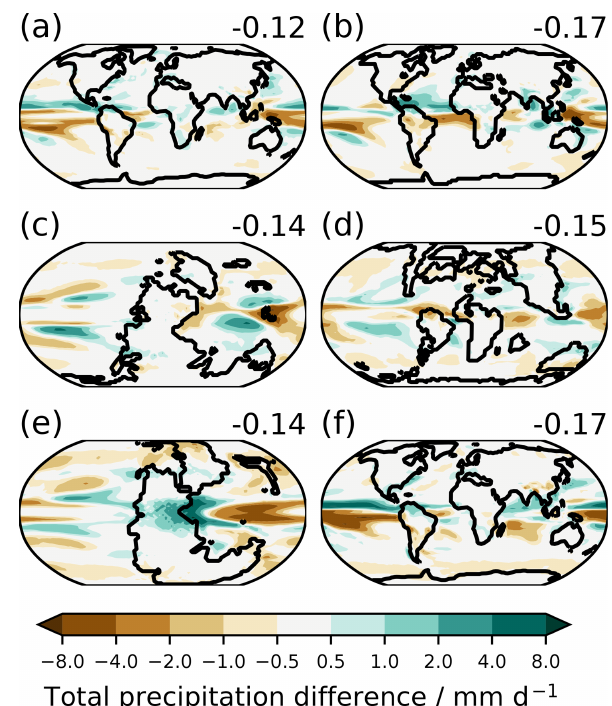
to 35% oxygen content for (a) PI-GEM 35 , (b) PI-CM 35 , (c) As- 10 10 CM 35 , (d) Ma-CM 35 , (e) Wu-CM 35 and (f) 4 × PI-GEM 35 . Global- 10 10 10 10 mean values (mmd − 1 ) are offset to the top right of each